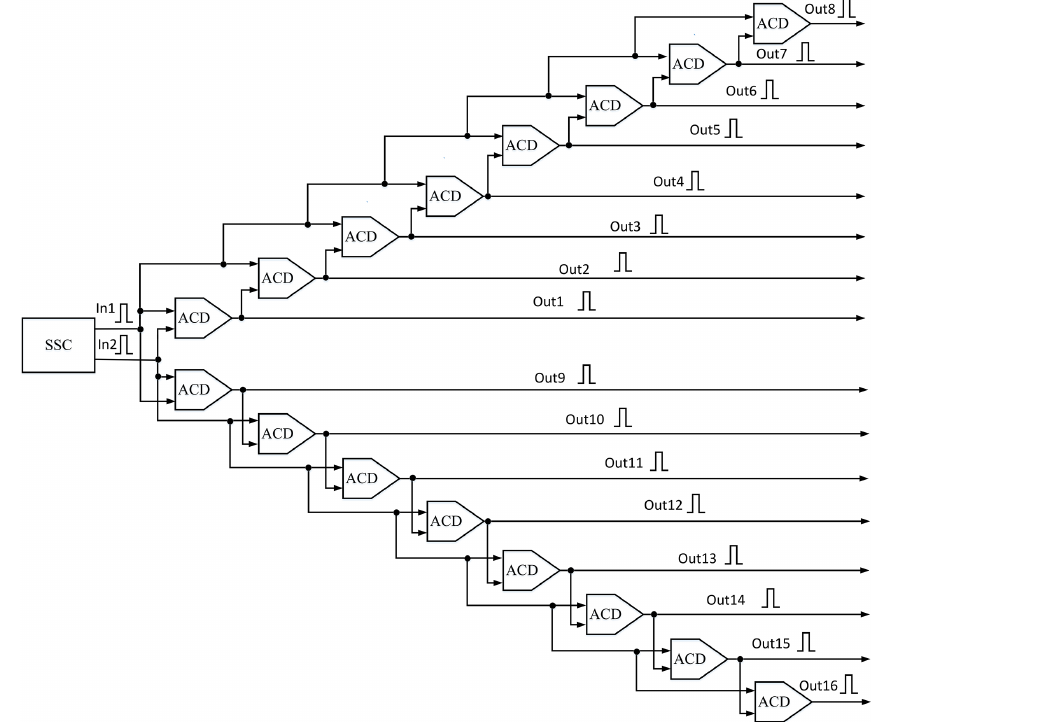
Figure 5. Proposed scheme of adaptive spike-to-rank coding (ASRC). Adaptive coincidence detection (ACD) is the essential block of the ASRC. The ASRC generates spikes that order codes according to the difference in time amount between the two spikes at its